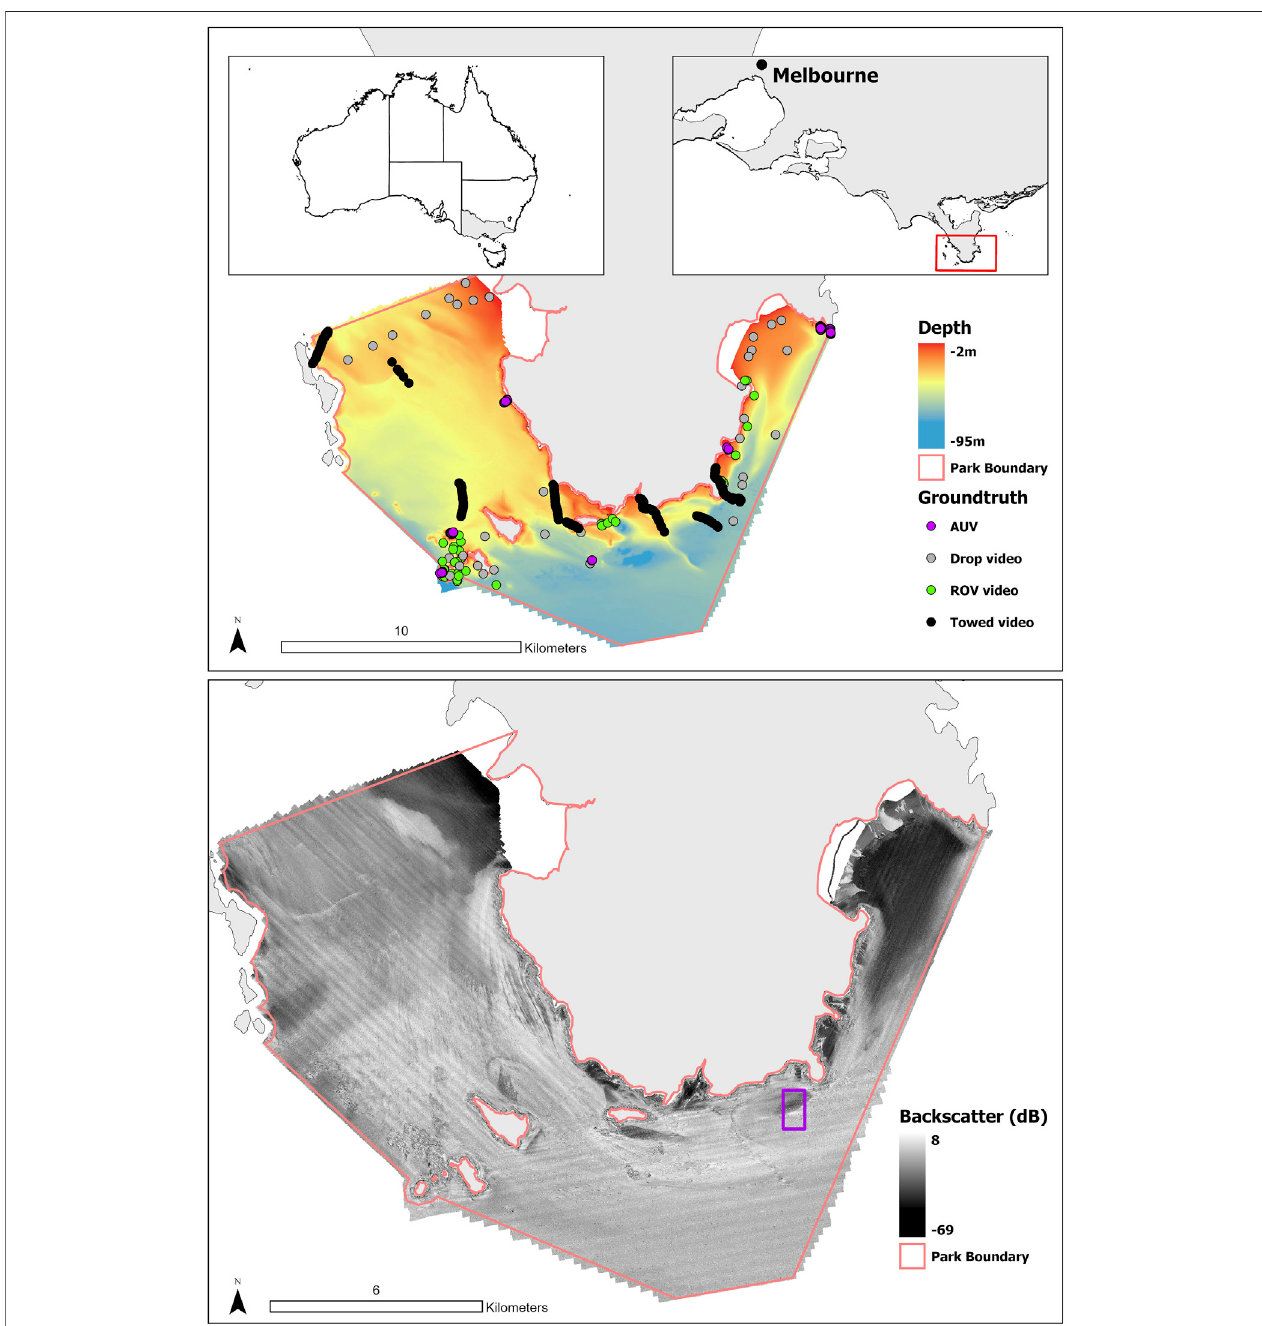
FIGURE 1 | Map of Wilsons Promontory Marine National Park bathymetry coverage, Victoria, Australia. Video groundtruthing sites are plotted, with gray representing drop video samples, green ROV samples, purple representing AUV samples and black towed video samples. The purple box represents the extents from Figures 4 , 5